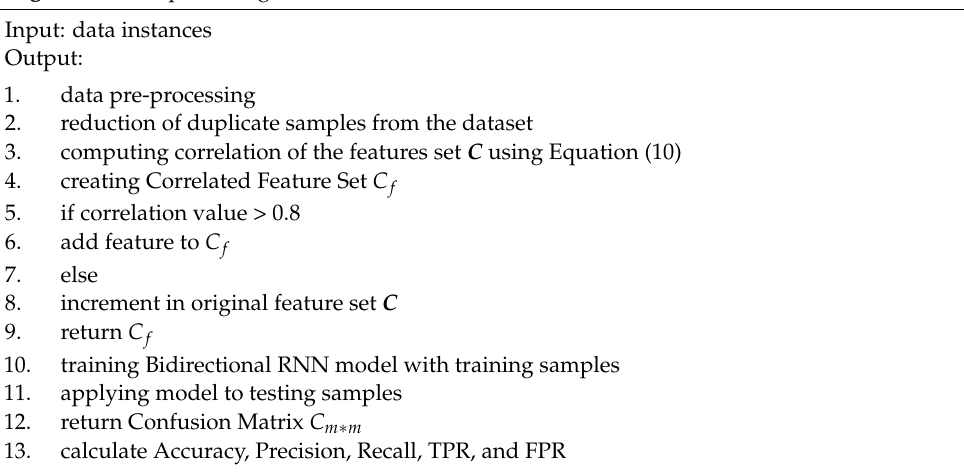
Algorithm 1 Proposed Algorithm Bidirectional